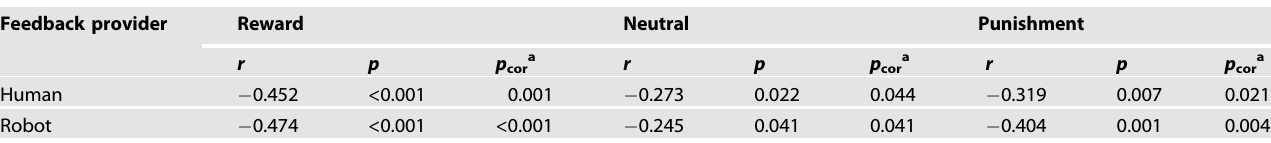
Table 3. Correlation between hit rate and CNV amplitude ( n =